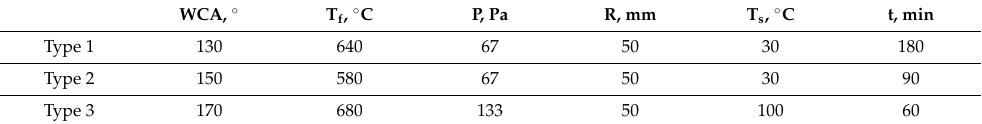
Table 1. Parameters of the coating deposition process in the manufacture of separation membranes. WCA, ◦ T f , ◦ C P, Pa R, mm T s , ◦ C t, min Type 1 130 640 67 50 30 180 Type 2 150 580 67 50 30 90 Type 3 170 680 133